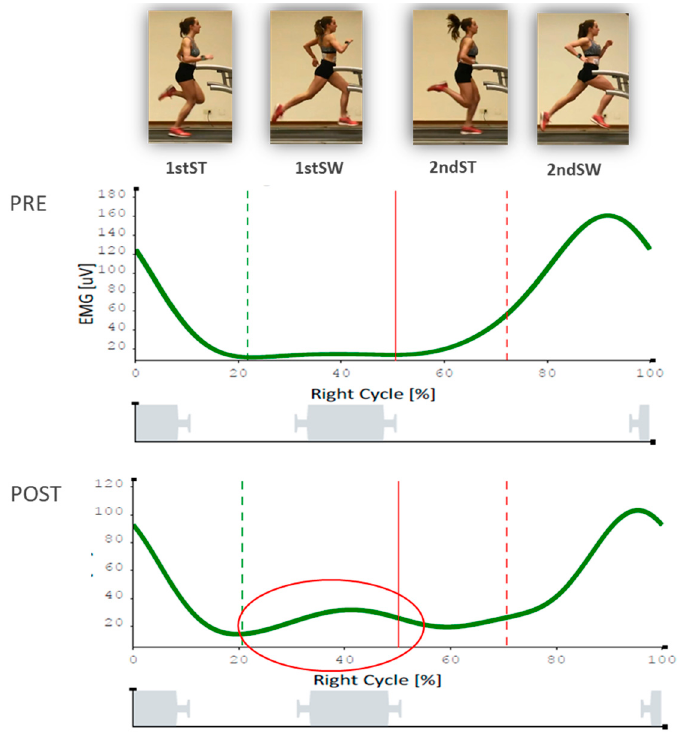
Figure 5. Gluteus medius (right) sEMG plot pre and post.